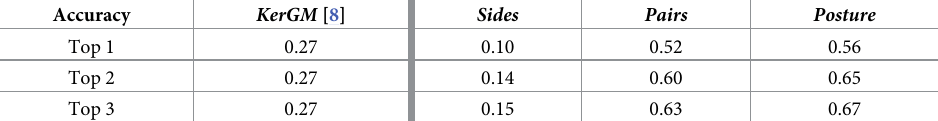
Table 1. Hypergraphical models Pairs and Posture achieved highest posture identification accuracy. Posture identi- fication accuracies across all N =1264 samples. Point-set matching models are listed across columns: KerGM [8] was compared to proposed EHGM models. Rows list the top x accuracy as a percentage of samples. The differences between top x accuracies across hypergraphical models highlight the difficulty in posture identification.